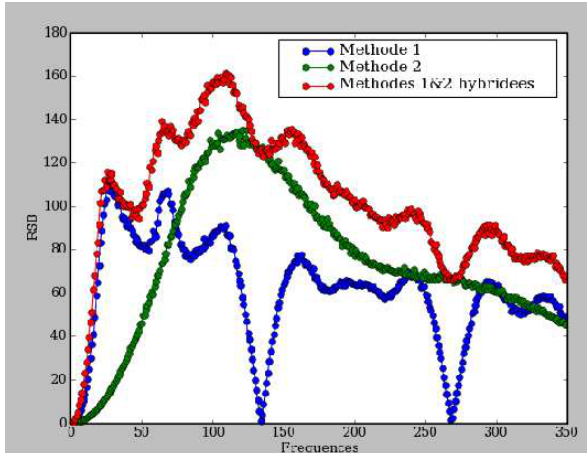
Figure 13: performance of restitution using MS correlation only (blue), tilt only (green), and MS and tilt correlation (red)